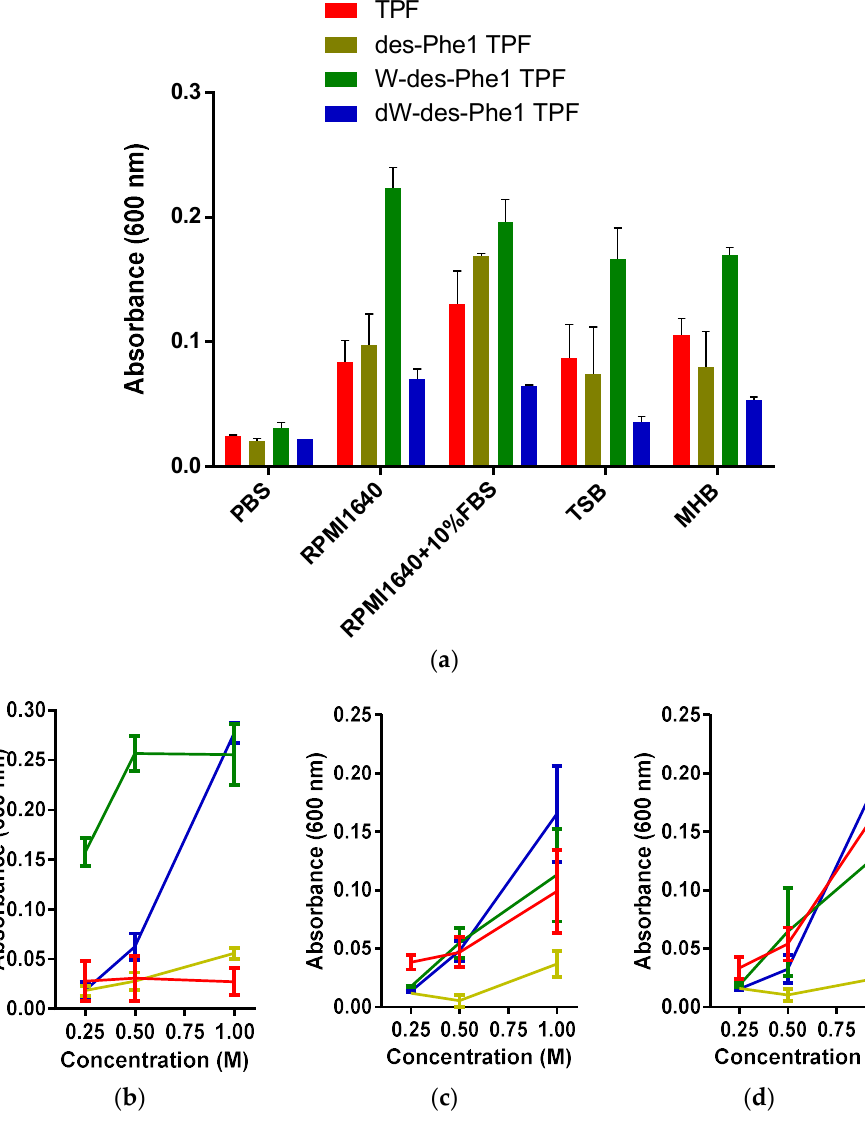
Figure 3. The absorbance of TPF and the analogs prepared in ( a ) a series of culture media, including PBS, RPMI1640, RPMI1640 with 10% FBS, TSB, and MHB; 0.25, 0.5, and 1 M of ( b ) Na 2 HPO 4 , ( c ) CaCl 2 , and ( d ) MgCl 2 solutions. Peptide solutions were prepared from 1 mg/mL, and the wavelength was set as 600 nm. The error bar represents the standard deviation (SD) with three replicates.